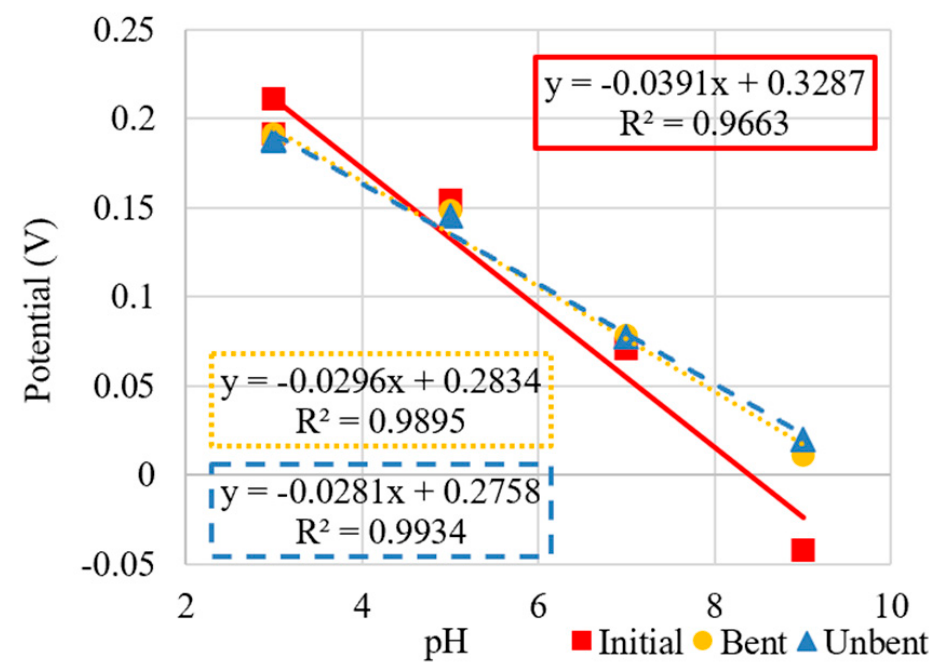
Figure 15. Sensitivity curves of PANI-ES composite in initial, bent, and unbent states.